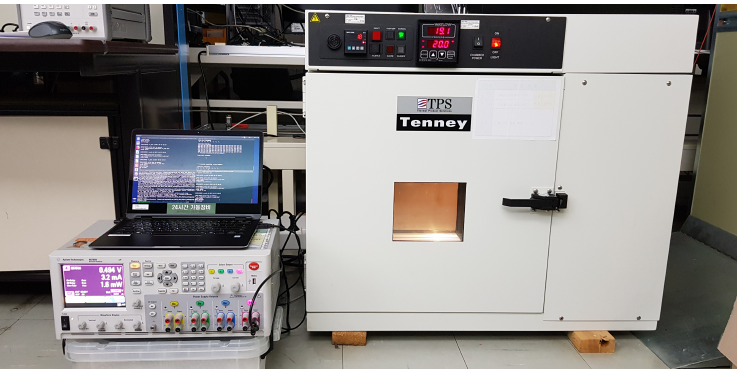
Figure 7. The experimental environment used to test the TEI phenomenon of the devices (sourced from [9]).